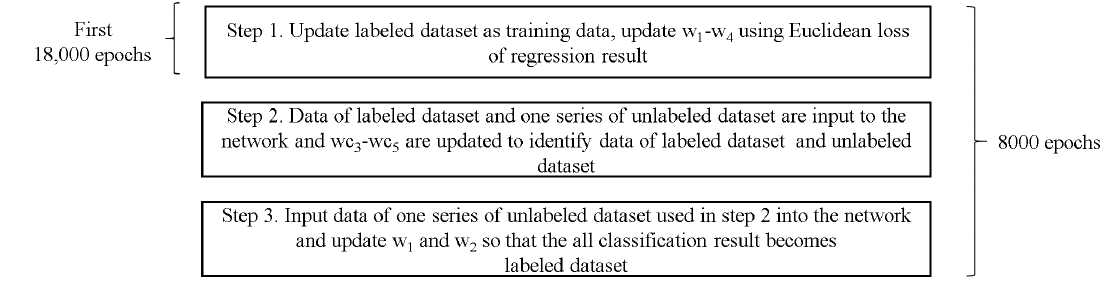
Fig. 5. Algorithm for network training.